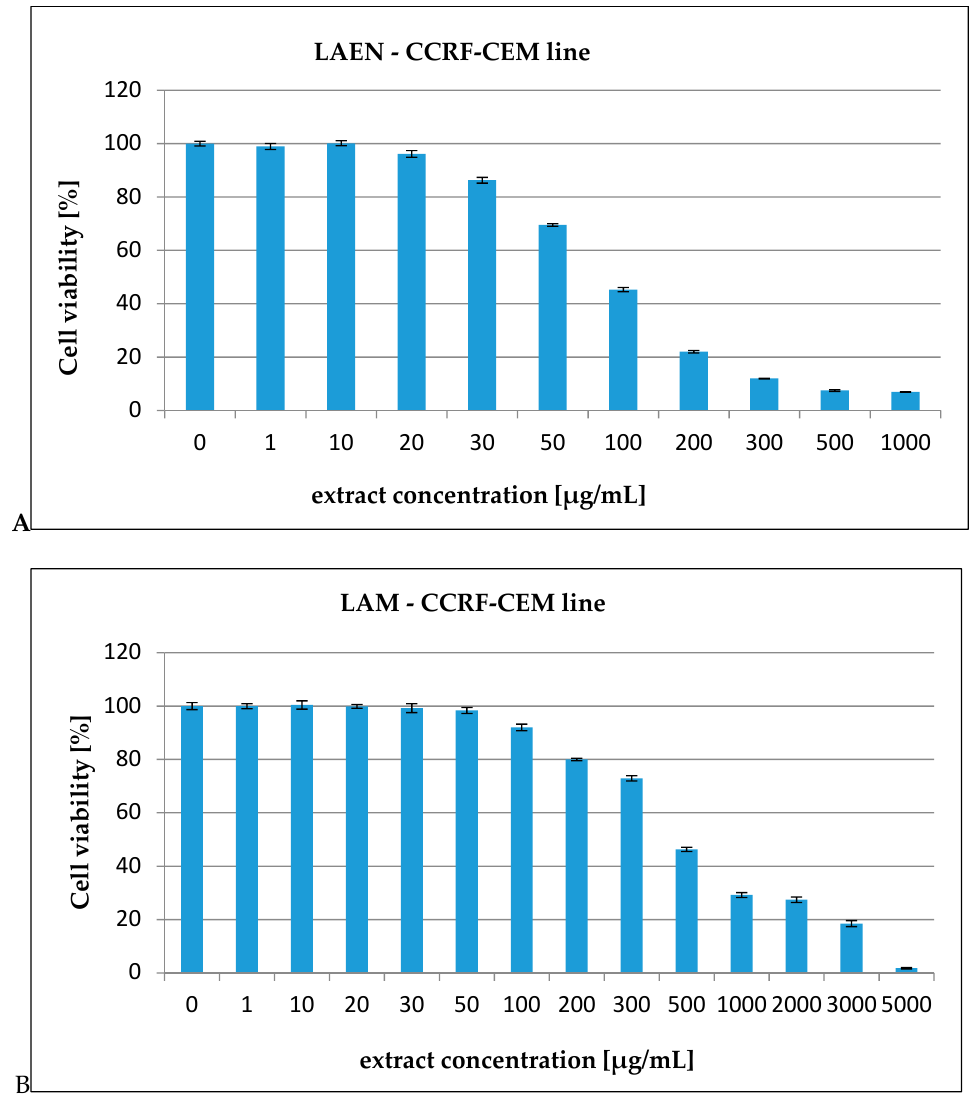
Figure 5. The valuation of the HL-60/MX2 cell line viability exposed to 24 h of increasing concentrations of: ( A )—LAEN extract and ( B )—LAM extract.